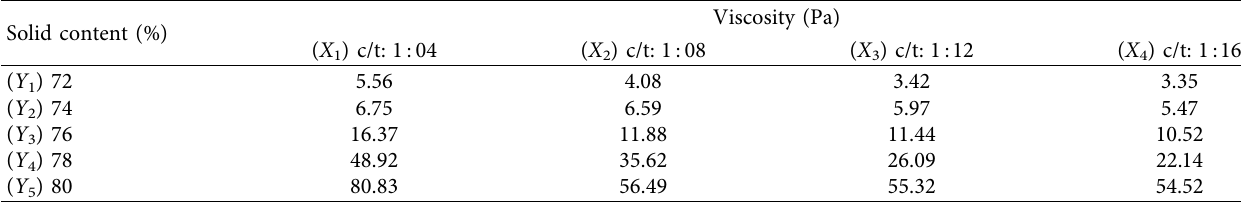
Table 9: ANOVA data of CUTB samples.